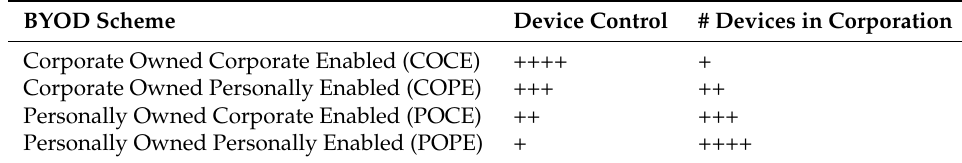
Table 2. Bring Your Own Device (BYOD) schemes and enterprise mobility schemes. BYOD